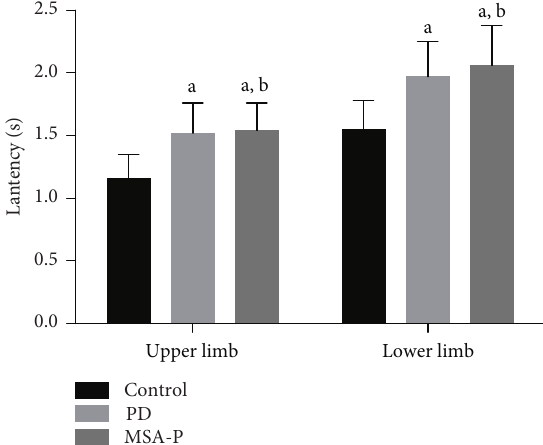
Figure 4: Comparison of SSR average latency between the MSA-P group, PD group, and control group. a p < 0 . 05 compared to control. b p > 0 . 05 compared to